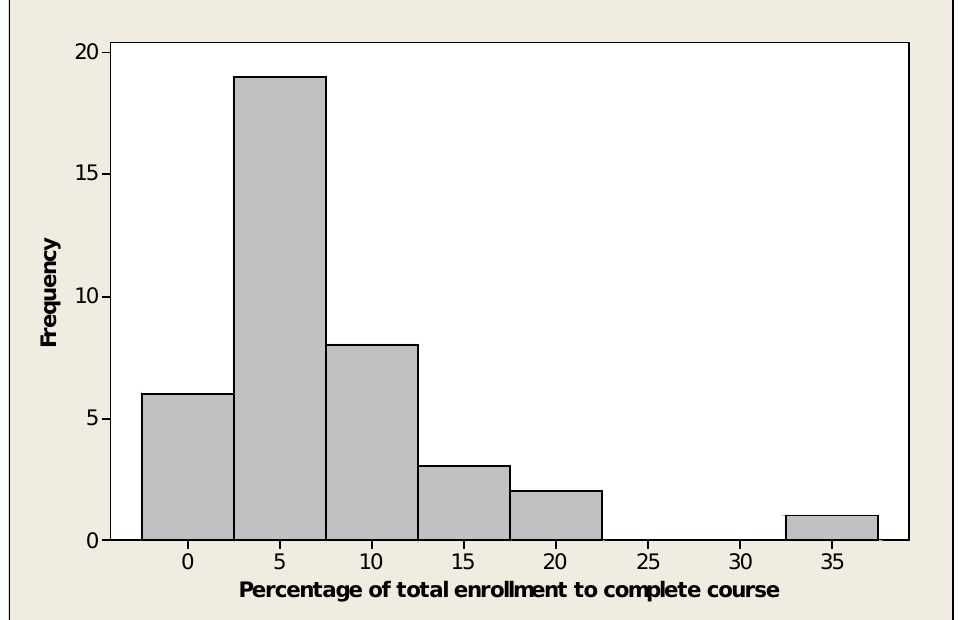
Figure 4 . Histogram of completion rates for the sampled courses ( n =